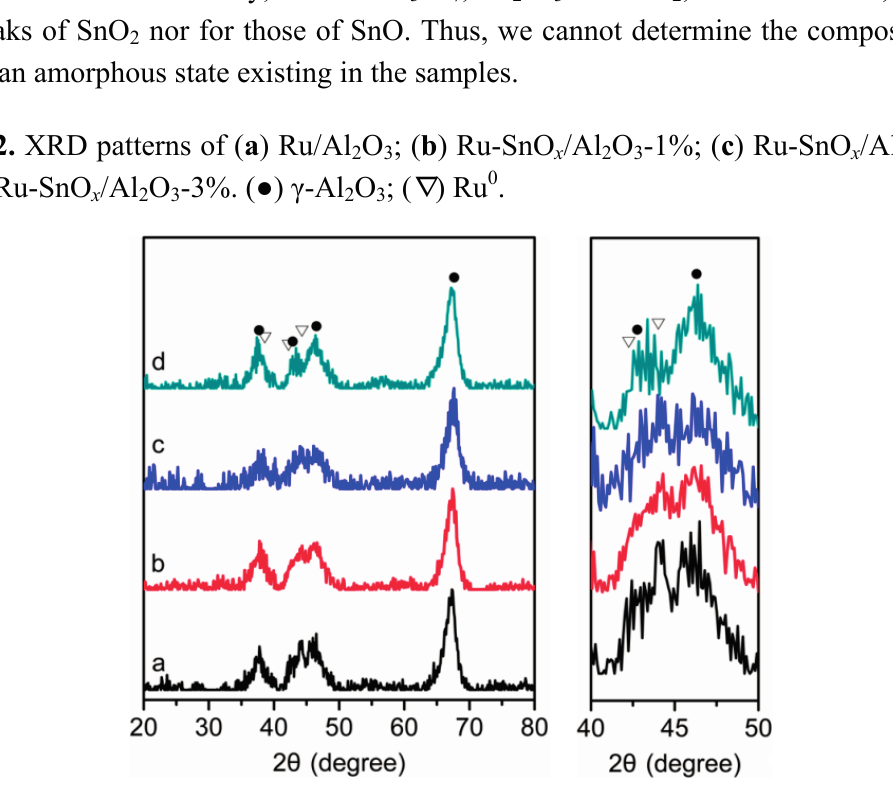
/Al O -1%; ( c ) Ru-SnO x 2 3